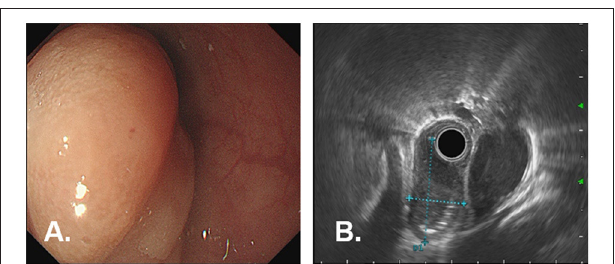
FIGURE 1 | Endoscopic findings in a 77-year-old woman with dysphagia. (A) Upper gastrointestinal endoscopy showed a large, rounded mass with smooth normal overlying mucosa, which is seen extending longitudinally along the lower esophagus, 30–34cm from the incisor teeth. (B) EUS shows a well-demarcated, hypoechoic mass in the esophagus wall, clearly margined from the surrounding adventitia.